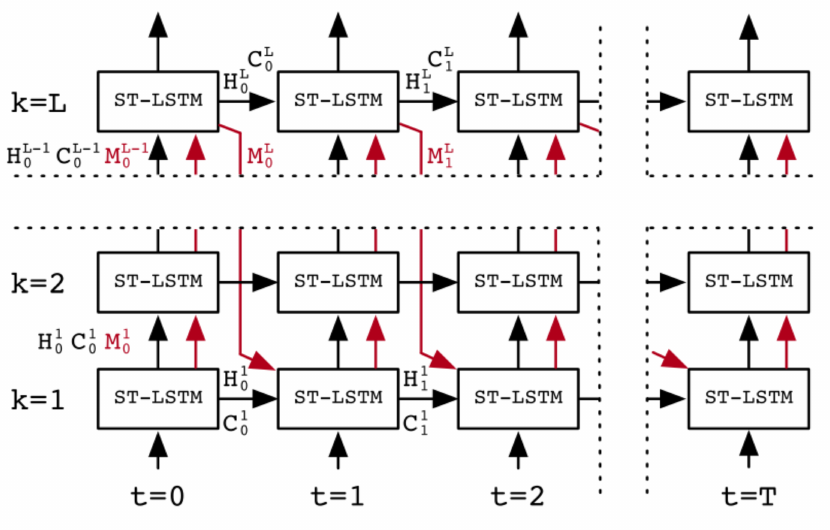
Figure 6. PredRNN with the ST-LSTM